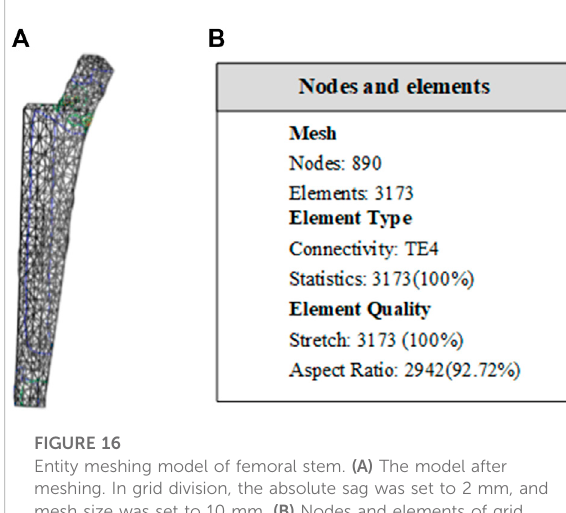
FIGURE 16 Entity meshing model of femoral stem. (A) The model after meshing. In grid division, the absolute sag was set to 2 mm, and mesh size was set to 10 mm. (B) Nodes and elements of grid division. The aspect ratio was 92.72% and the streth 100%, showing the meshing result is